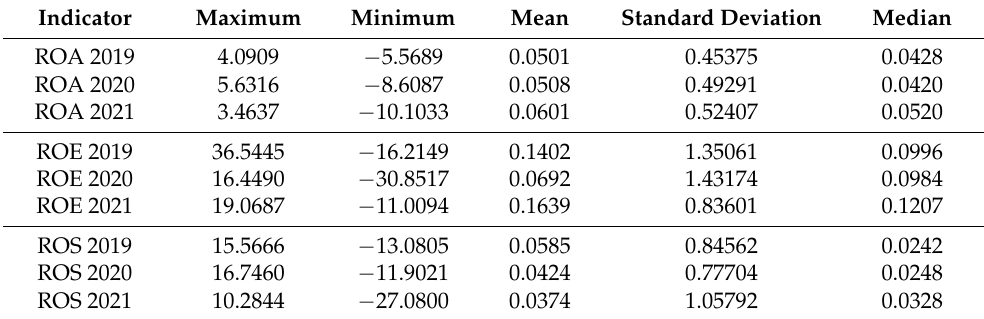
Table 5. Descriptive statistics for very large companies. Source: own